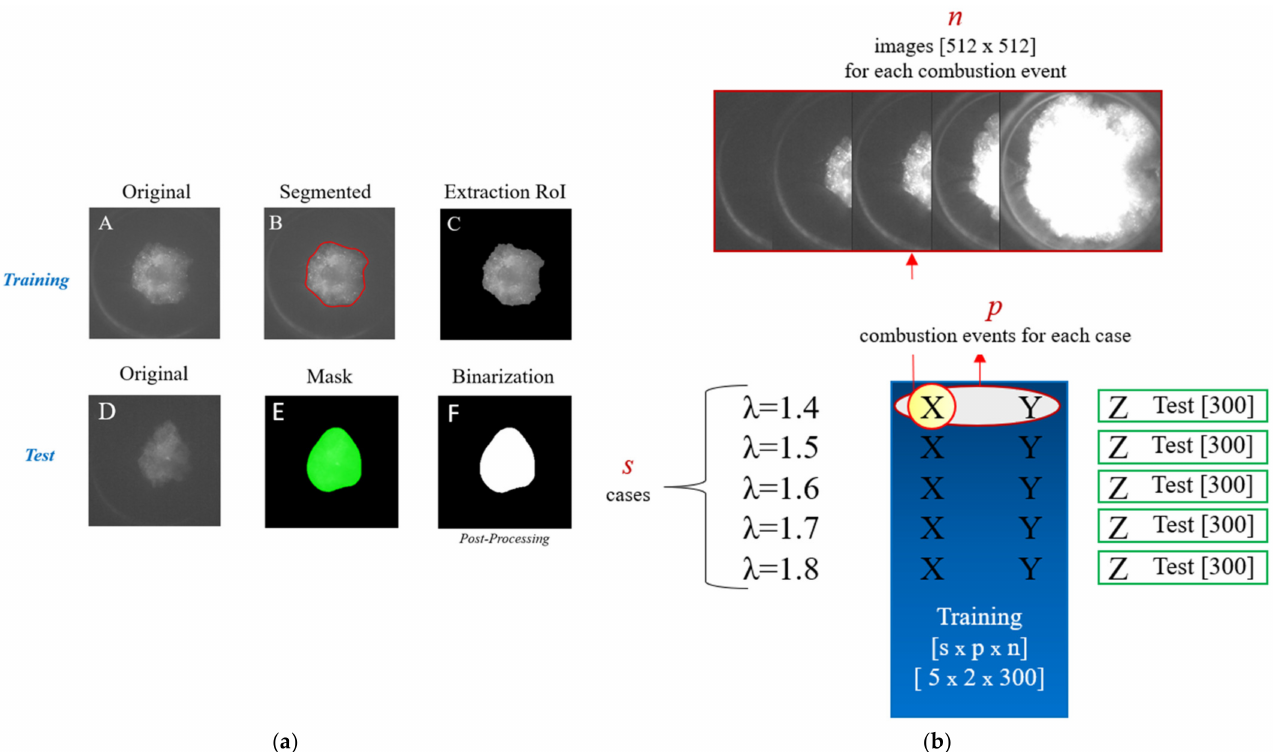
Figure 5. ( a ) Extraction of the region of interest during the training session and determination of the binarized image from the Mask. This latter is obtained during the test session starting from the outputs of the training session. ( b ) Representation of data division to perform training and test of the proposed